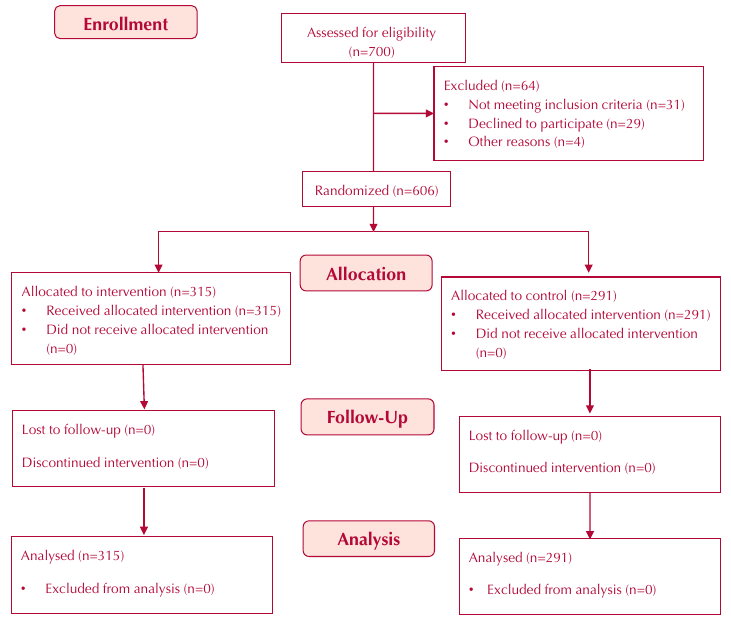
Figure 1. The flow diagram of study participants.